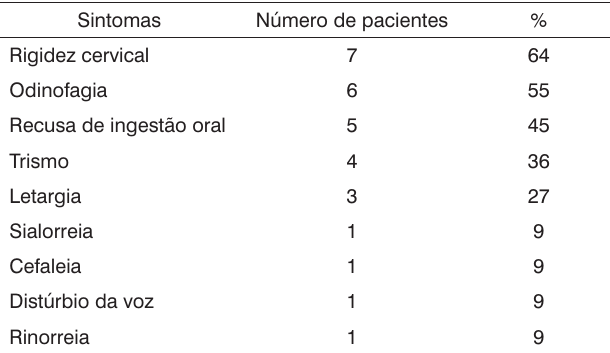
Tabela 1. Sintomas apresentados à admissão.